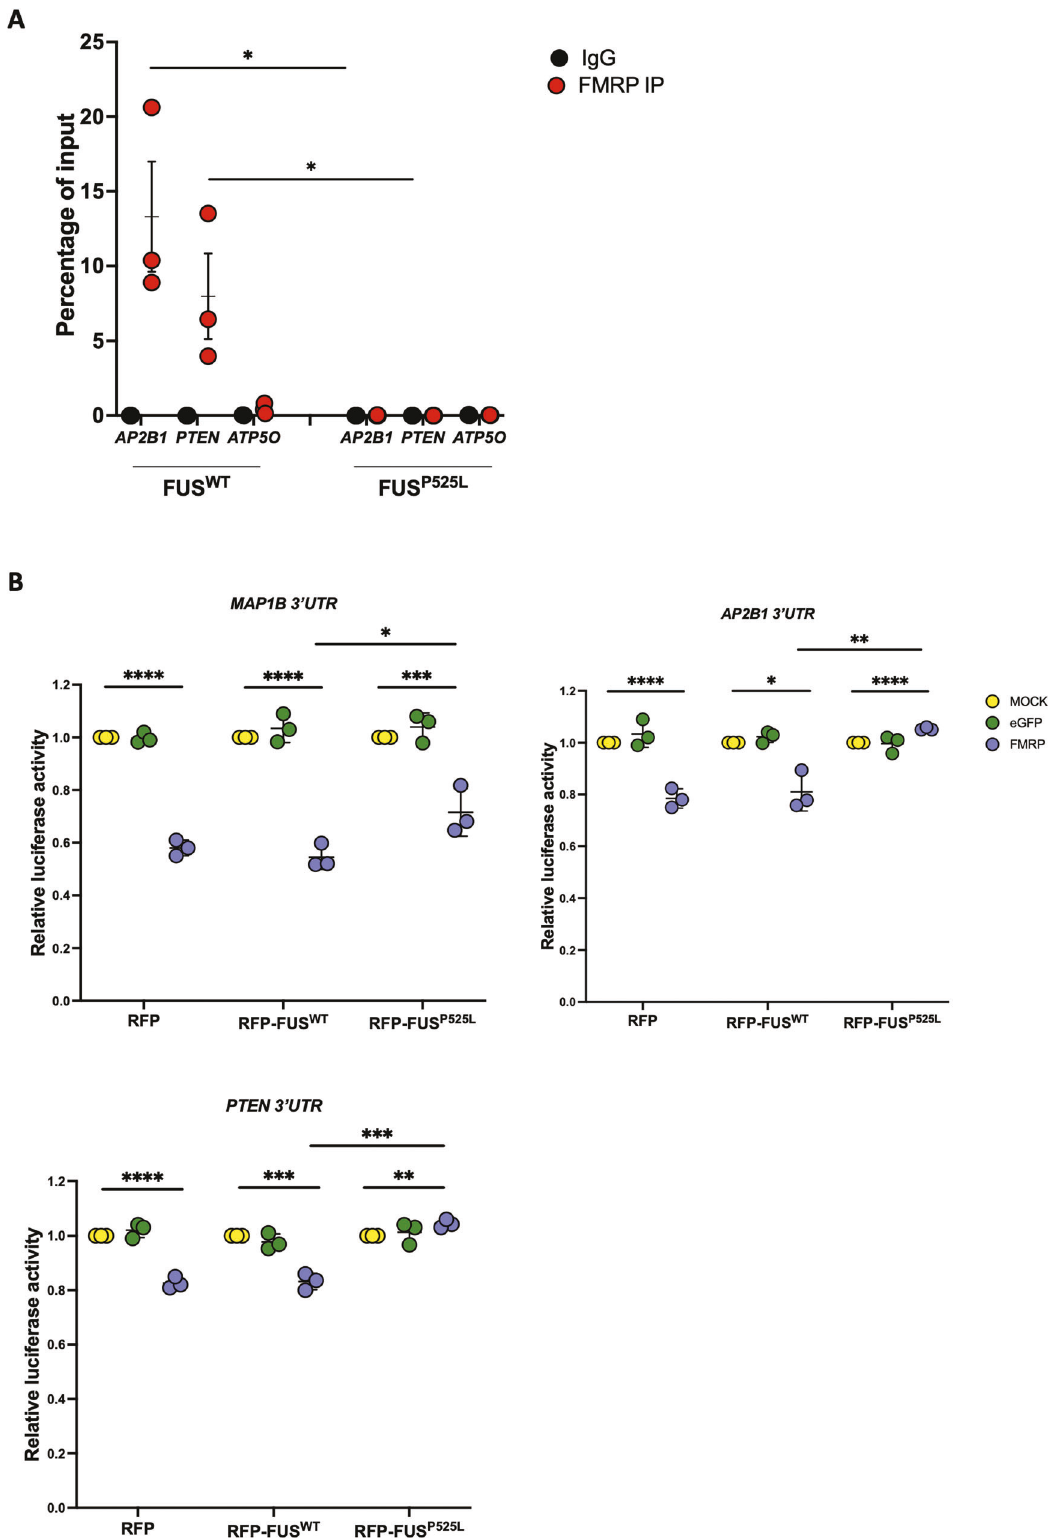
expressed genes was performed using Qlucore Omics Explorer software and GO pro fi ler tool, respectively. PAR-CLIP reads and transitions were derived from published data [15]; only ratio of T to C transitions > 1 (comparing FUS P525L vs. FUS WT ) were considered for the comparison with the FMRP HITS-CLIP data [32].